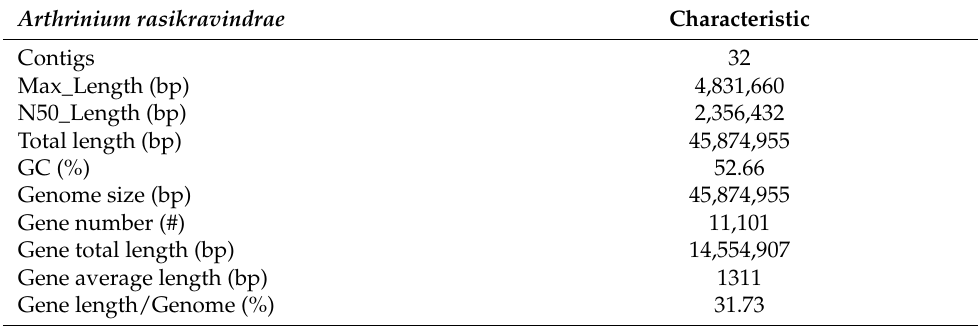
Table 1. Gene assembly data of A. rasikravindrae